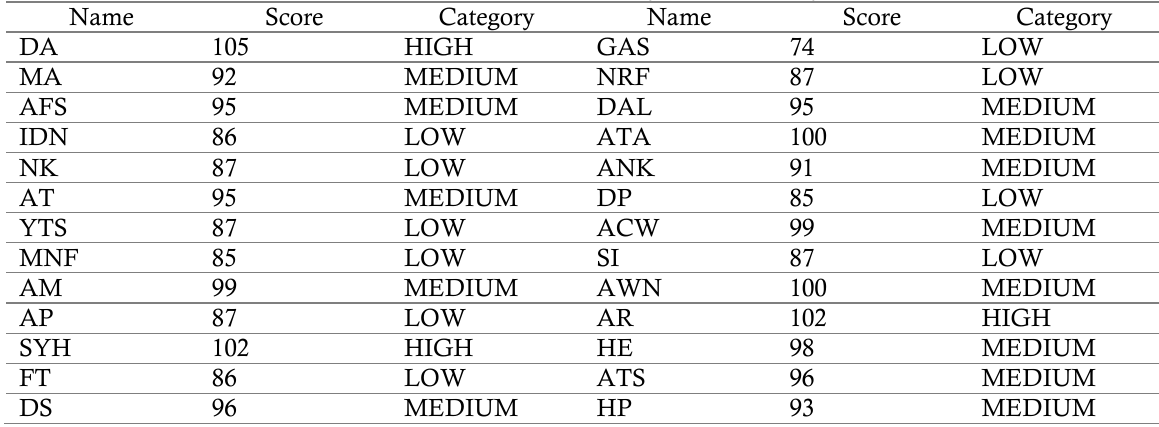
Table 1 Pre-testResult of Subject of the